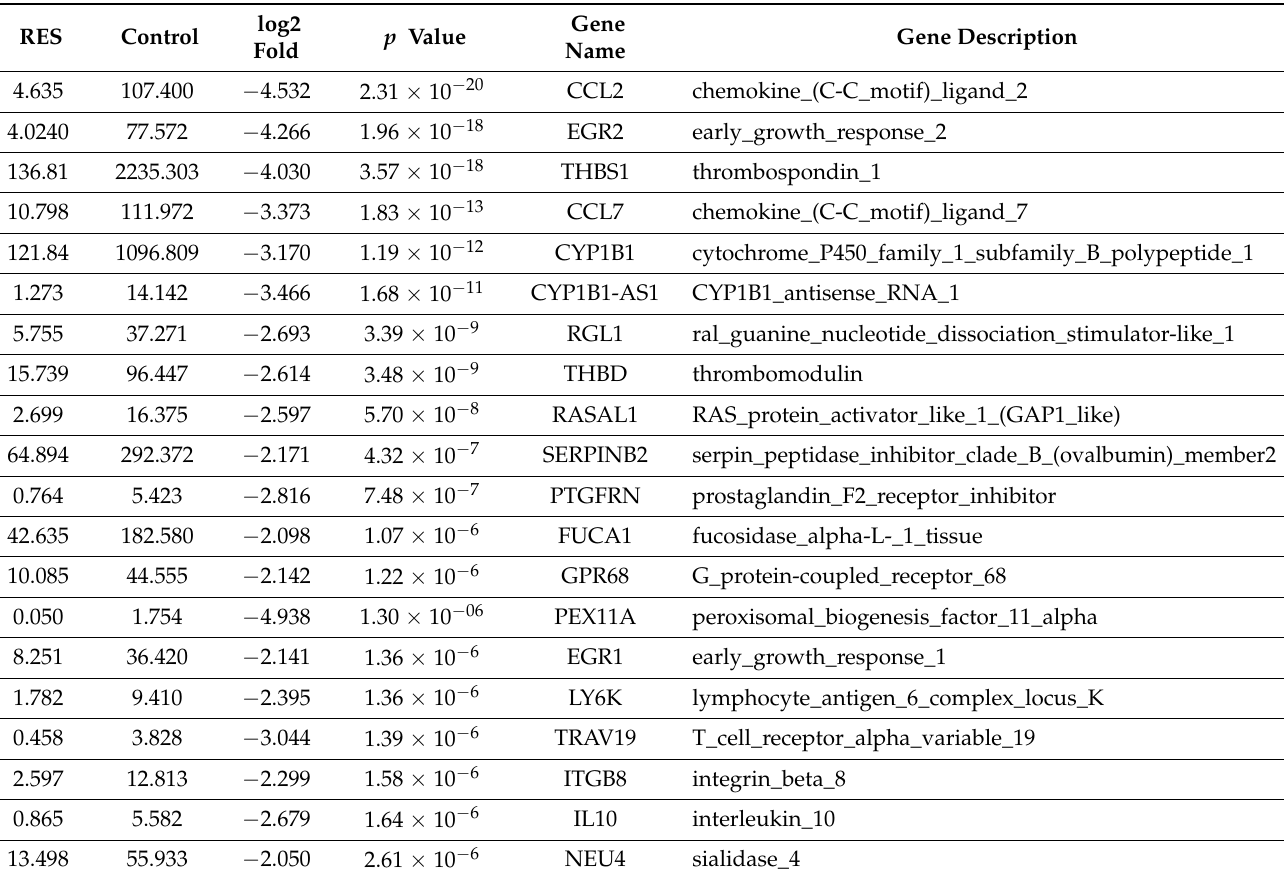
Table 1. Genes downregulated with resveratrol alone *.